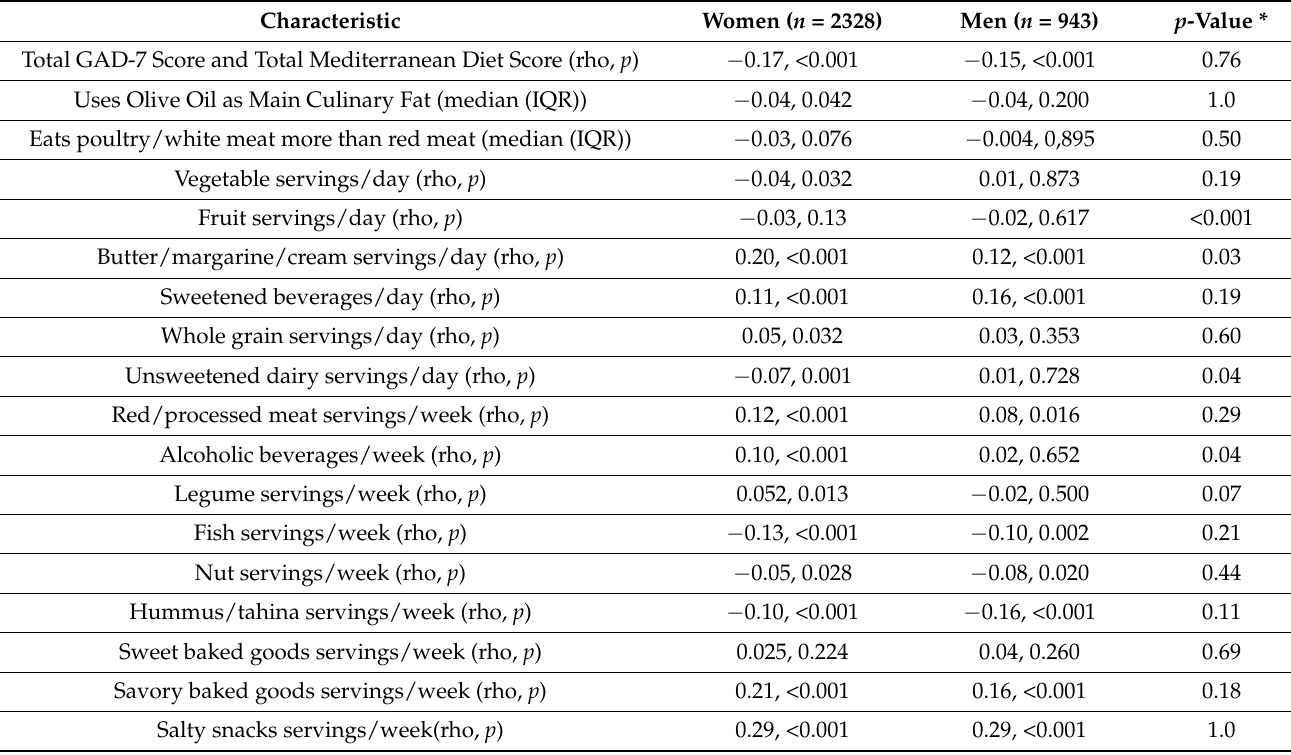
Table 4. Associations between GAD-7 score and Mediterranean Diet